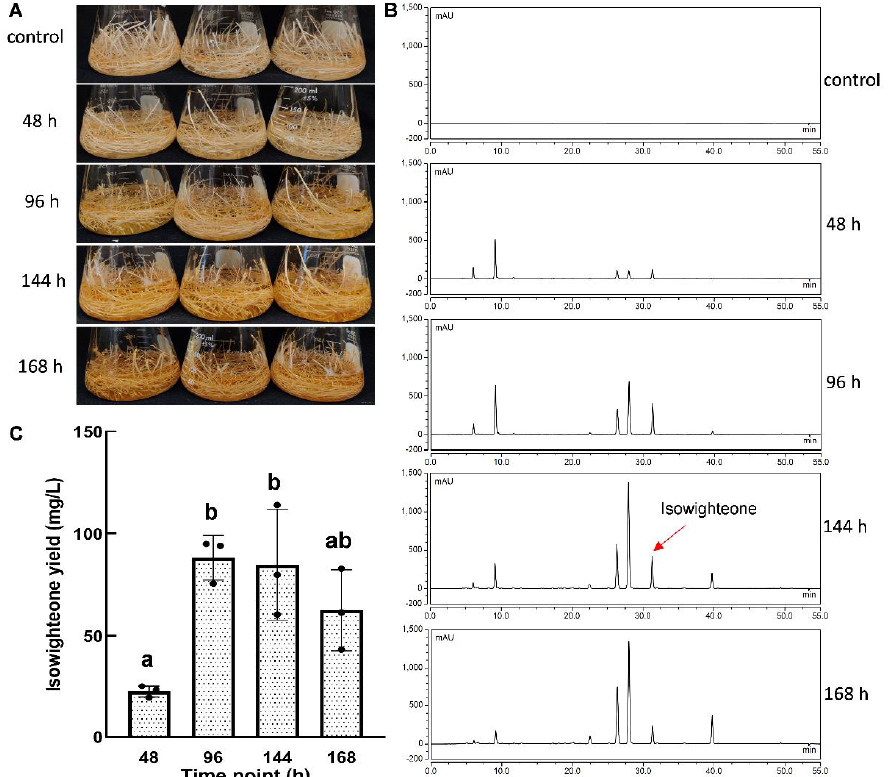
Figure 5. Time course of isowighteone yield in the elicited culture medium of 12-day-old pigeon pea hairy root cultures. ( A ) Change in phenotype after elicitor treatment. ( B ) HPLC chromatogram of culture medium extract after elicitor treatment for different time points. All chromatograms were monitored at 260 nm. ( C ) Comparison of isowighteone yield in the culture medium of hairy root cultures elicited for different time points. Yields are expressed in mg/L. Each bar represents the average of three biological replicates. Error bar represents standard deviation. Statistical analysis was performed using one-way ANOVA with Tukey’s multiple comparisons test. The lower-case letters above the column represent significant (between different letters) or non-significant (between the same letter) statistical differences. (Significance level between a and b, p < 0.05).